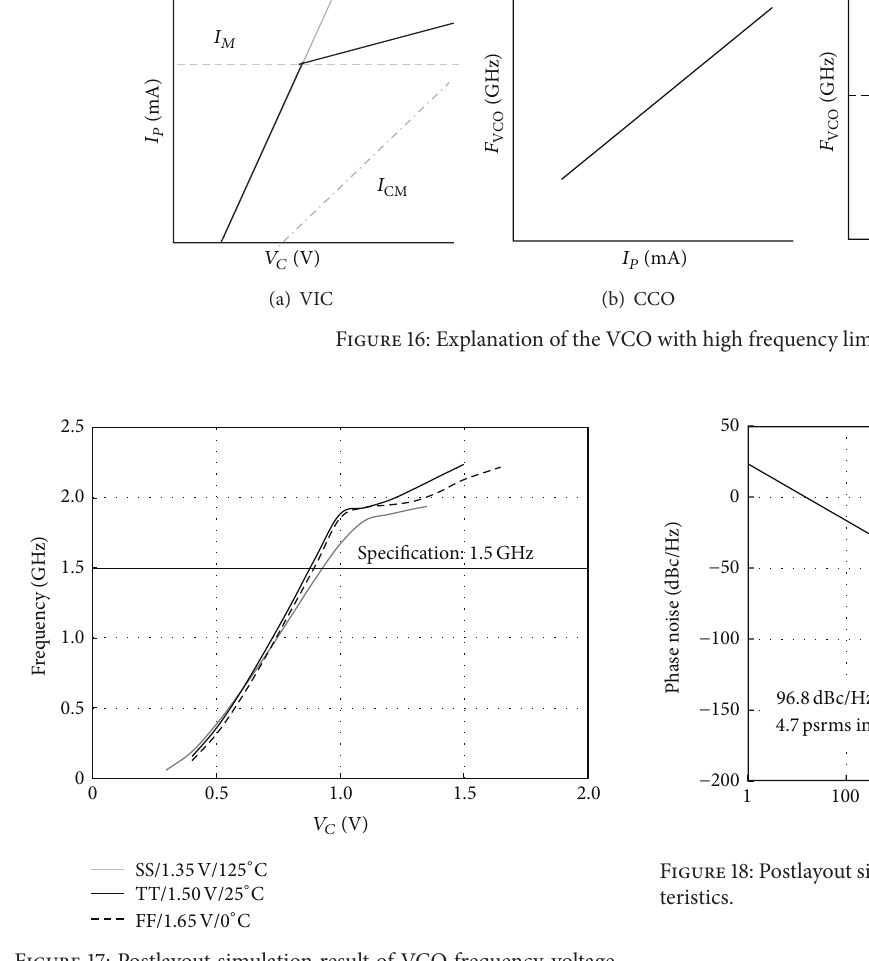
Figure 17: Postlayout simulation result of VCO frequency-voltage characteristics.